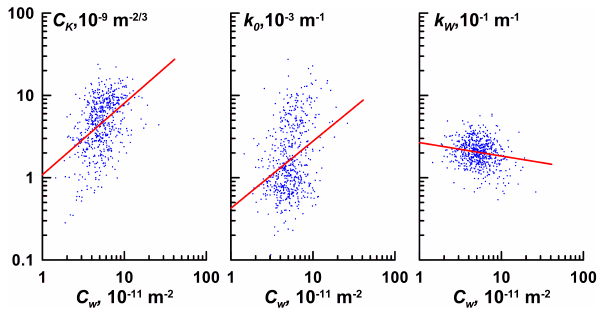
Fig. 5. Scatter plots for pairs of the spectral parameters presented in Table 2 for September–November 2004 at 40km